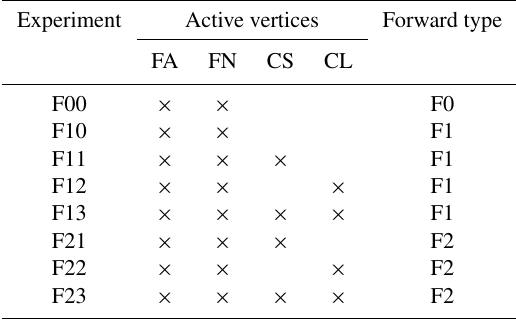
Table 4. List of experiments: the names are provided in the first column. The active vertices in each experiment are indicated with the × symbol. The last column indicates the name of the aerosol model used to simulate the